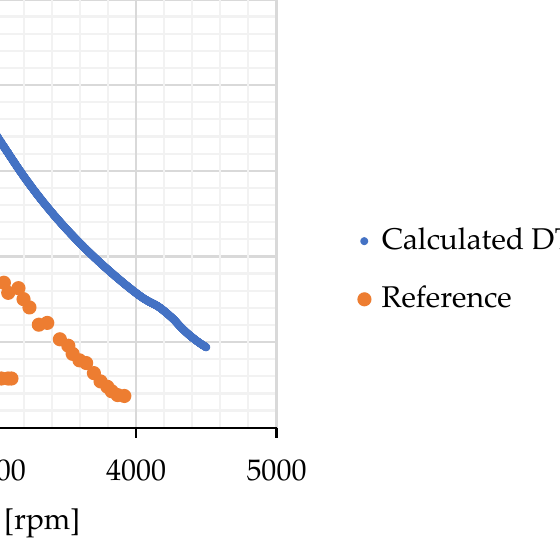
Figure 9. Comparison between measured DTE in spur gear pair [26] and calculation. It can be found that the pattern of dynamic transmission error results matches the experimental results, especially the frequency ranges of harmonics as seen in Figure 9.